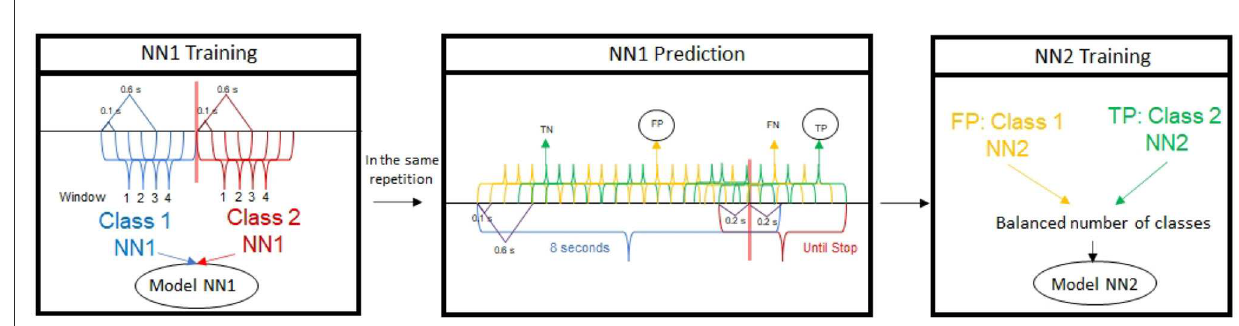
FIGURE4 The training diagram for creating the two training models is as follows: in each training data package, the NN1 is first applied to a temporal window close to the Laser Obstacle, and then each epoch is predicted with the same repetitions over a wider temporal window. False Stops and True Stops are selected and balanced to be used in the NN2 model creation.